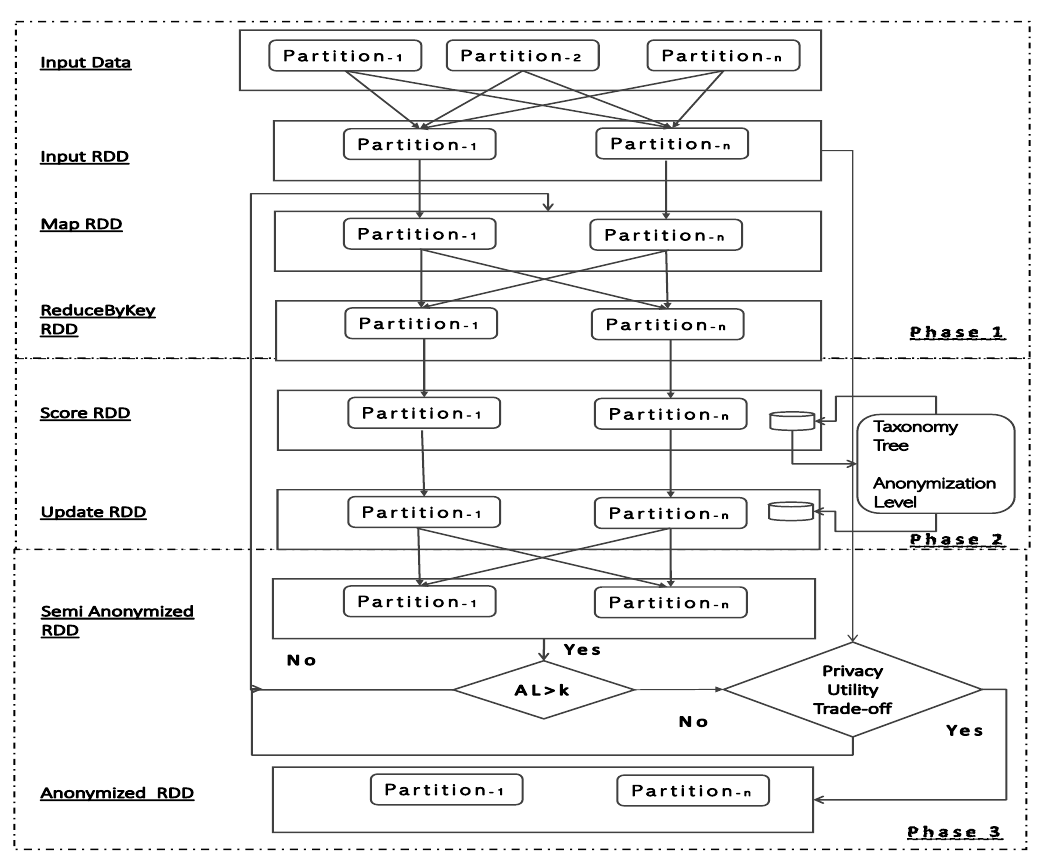
Figure 3. Proposed Spark subtree